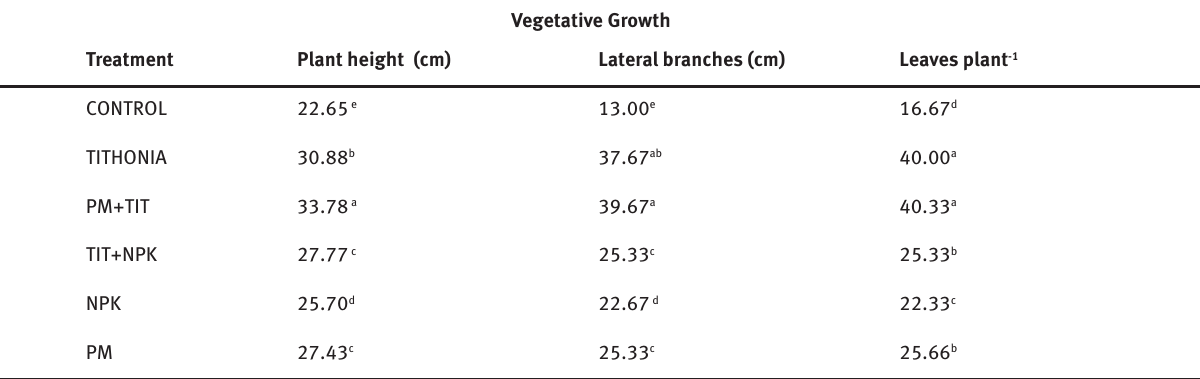
Table 3: Effect of thitonia diversifolia, poultry manure and NPK fertilizer the height (cm), lateral branches and leaves number of summer squash